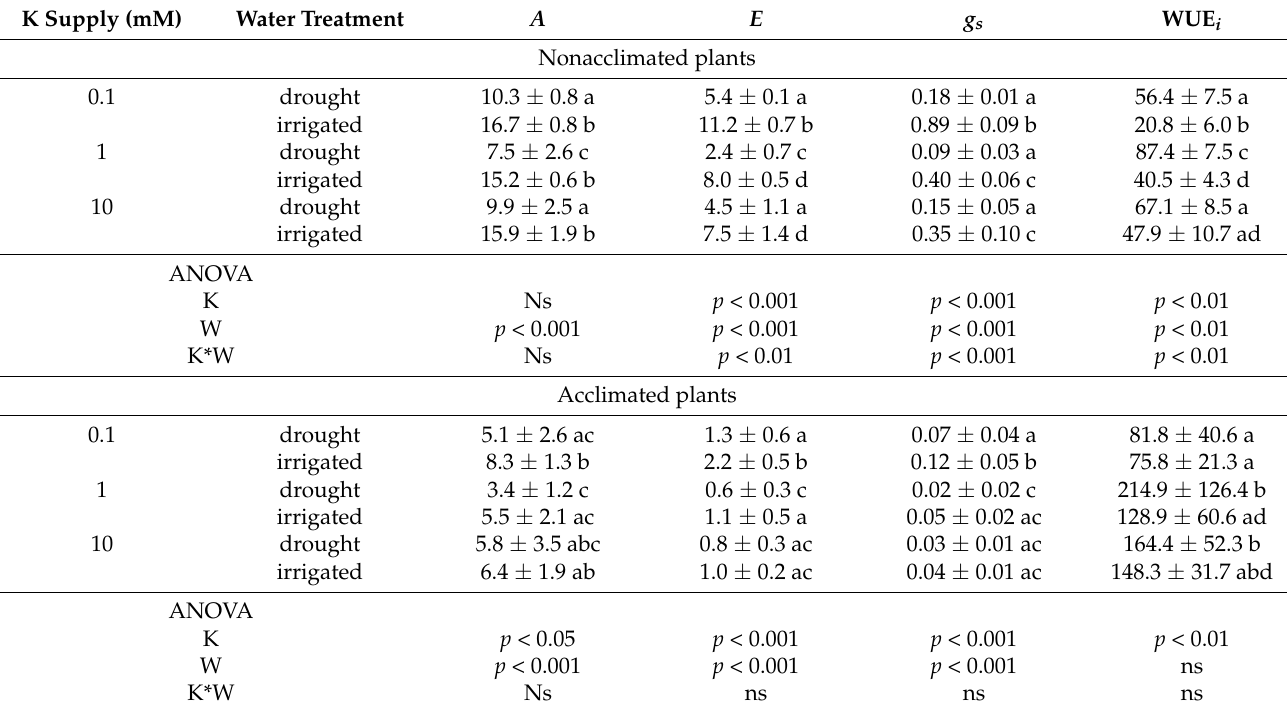
Table 8. Photosynthesis ( A ), transpiration rate ( E ), stomatal conductance ( g s ) and intrinsic water-use efficiency (WUE i ) in plants that were watered every three days (irrigated), or received one cycle of drying/watering (nonacclimated) or four cycles (acclimated). Photosynthesis and gas exchange were measured after one or the four cycles of drying/watering, in comparison with plants that were irrigated normally. In the irrigation, plants had different K regimes (0.1, 1 and 10 mM K). Within each column, means ( ± standard deviation) followed by the same letter are not significantly different (LSD Test, p < 0.05). Units: A , µ mol CO 2 m − 2 s − 1 ; E , mmol H 2 O m − 2 s − 1 ; g s , mmol m − 2 s − 1 ; WUE i , µ mol CO 2 · mmol − 1 . K and W in ANOVA represent potassium and watering regime,